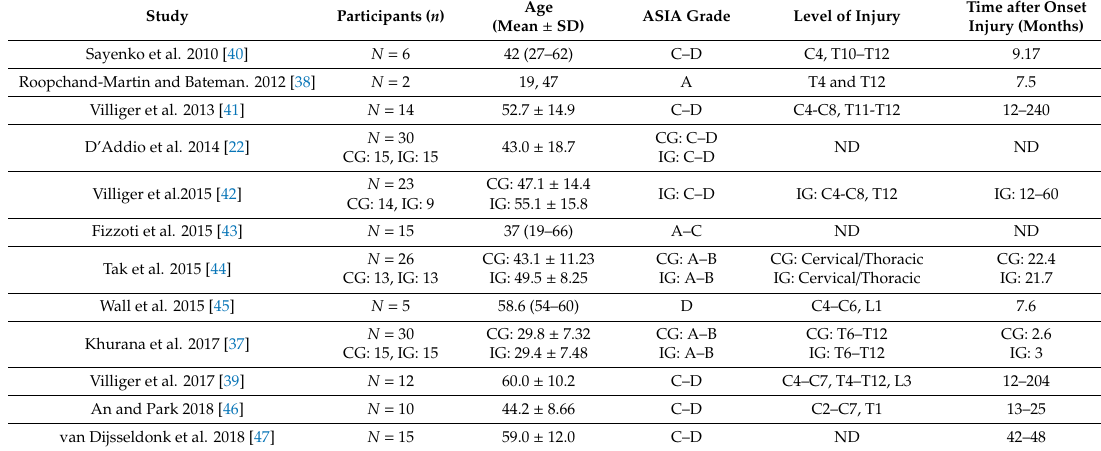
Table 1. Main characteristics of the participants in each